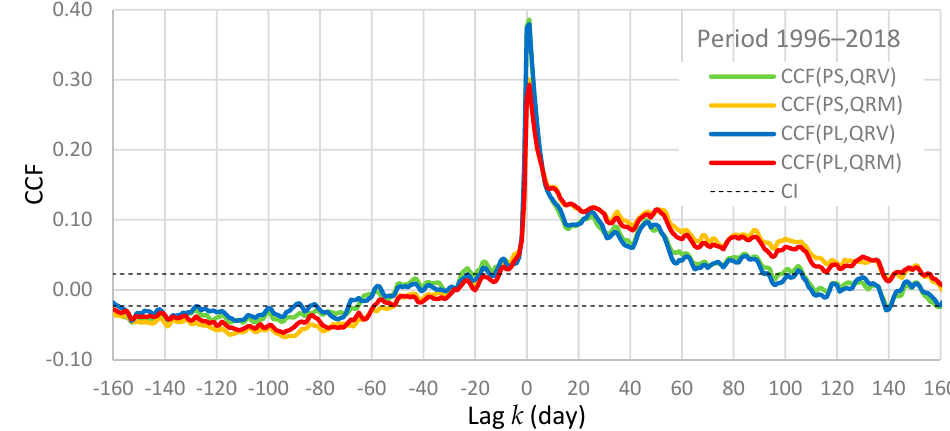
Figure 6. Cross-correlation function (CCF) between rainfall and discharge, where the input time series is rainfall from MS Sinj (P S ) and MS Livno (P L ) and the output time series is discharge from the spring Rumin Mali (Q RM ) and Rumin Veliki (Q RV ), for period 1996–2018. CI—confidence interval.